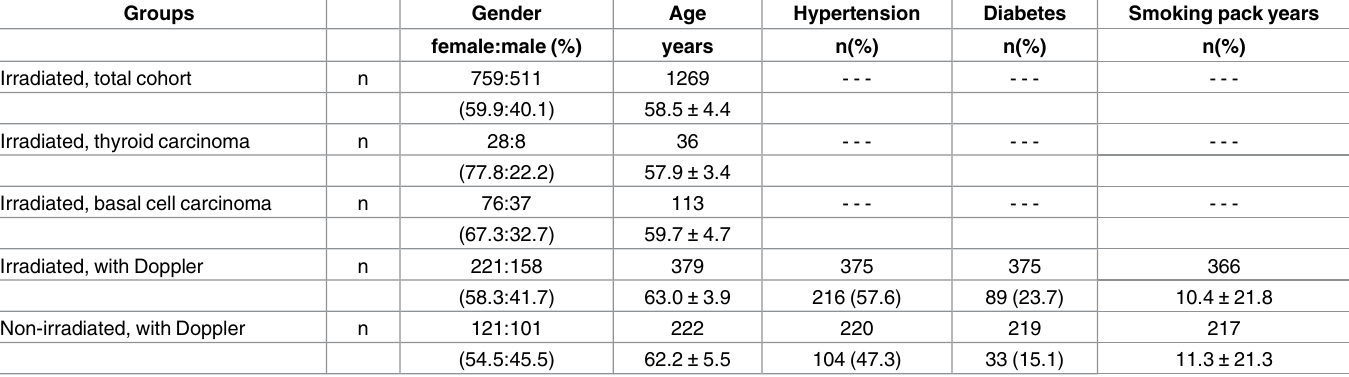
Table 1. Demographic and clinicopathological characteristics of the total cohort, thyroid carcinoma, basal cell carcinoma and individuals exam- ined by Doppler ultrasound.